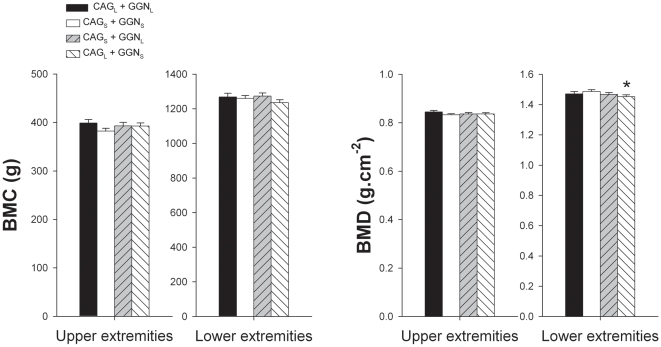
Bone mineral content (BMC) and areal bone mineral density (BMD) of the upper and lower extremities.Subjects were grouped as CAG short (CAGS) if harboring repeat lengths of ≤21 and CAG long (CAGL) if harboring repeat lengths of >21. The cutoff point for GGN short (GGNS) was GGN repeat polymorphism ≤23, otherwise subjects were included in the GGN long (GGNL) group. Four haplotypes combinations were defined as: CAGL + GGNL, CAGS + GGNS, CAGS + GGNL, and CAGL + GGNS. * P<0.05 compared to CAGS + GGNS; $ P<0.05 compared to CAGL + GGNL.